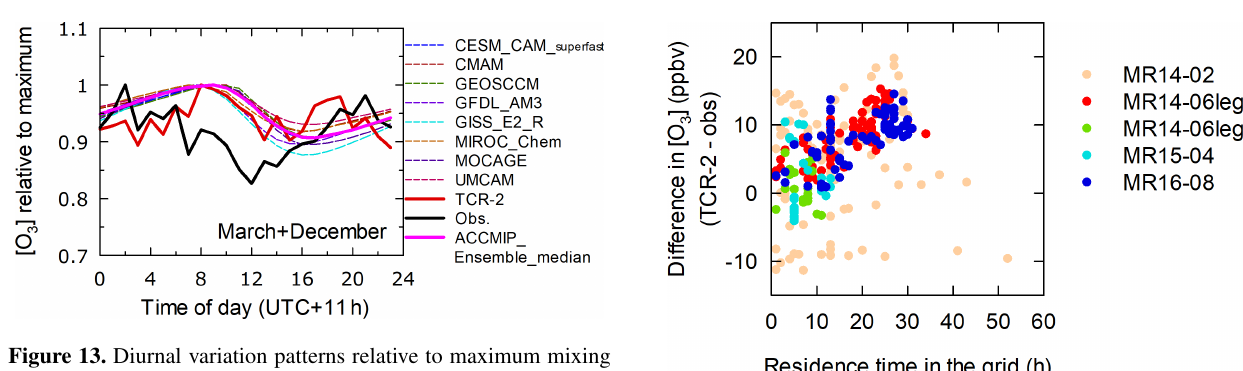
Figure 13. Diurnal variation patterns relative to maximum mixing ratios from observations (black), TCR-2 (red), and members and ensemble median of ACCMIP for domain 3 (0–15 ◦ N and 150– 165 ◦ E). Data from March and December are merged. Figure 14.